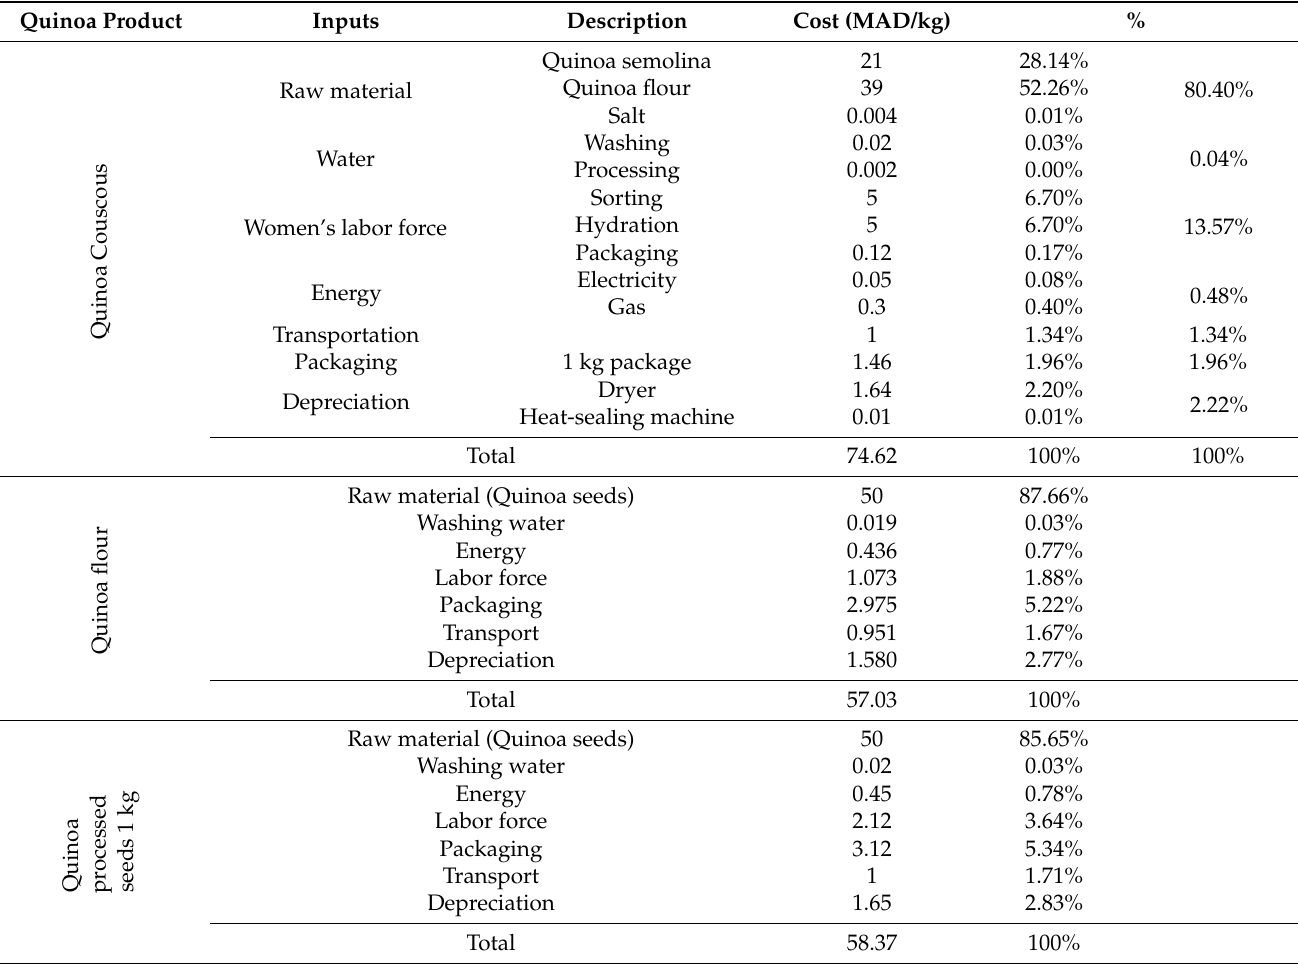
Table 7. Cost breakdown for quinoa couscous, flour and processed seeds production. 1 USD= 9 MAD. Quinoa Product Inputs